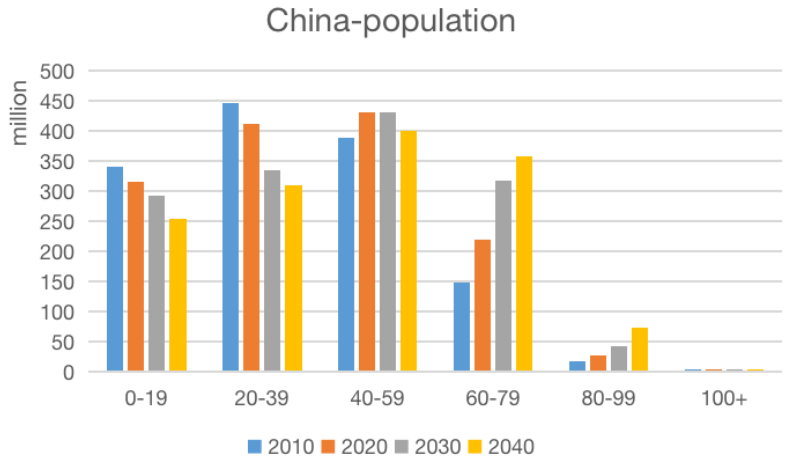
Figure 1. Estimated future age cohorts within China’s population.